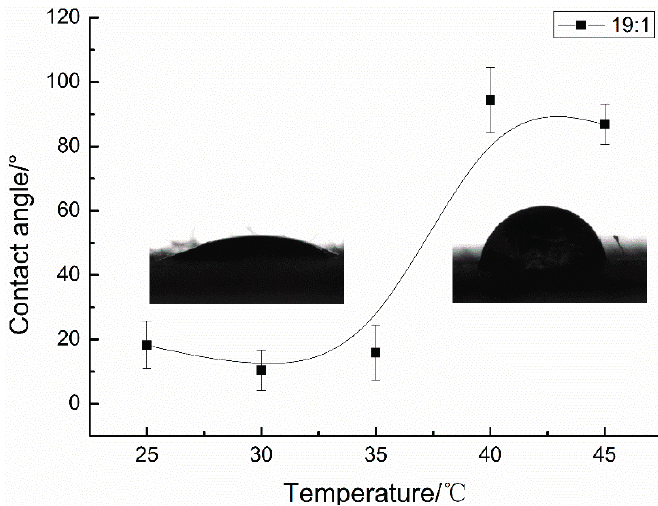
Figure 6. Contact angle measurements of the P(NIPAAm- co -NHMAAm) (19:1) grafted cotton fabrics at different